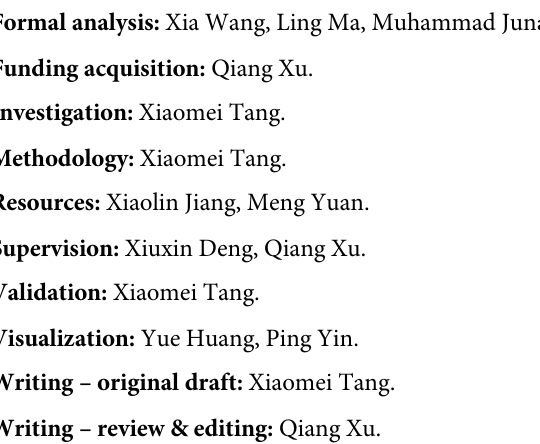
S1 Table. Number of paired-end reads counted by Illumina sequencing technology. Note: ATL and SWO represent Atalantia and sweet orange, respectively. The treatment group and control group were inoculated with Xcc and sterile water at 6 h, 24 h, and 48 h. S2 Table. List of 8 overlapping differentially expressed genes 48 h after Xcc inoculation in Atalantia and sweet orange. Note: fold-changes of gene expression level (fragments per kilo- base of transcript per million mapped reads, FPKMs) were normalized to the FPKM of the control (inoculation with sterile water at 48 h). ‘-’ indicates down-regulation. S3 Table. Differentially expressed genes (DEGs) in Atalantia and sweet orange after Xcc inoculation. ATL and SWO represent Atalantia and sweet orange, respectively. T6, T24, and T48 represent the treatment time points (inoculation with Xcc at 6 h, 24 h and 48 h); C6, C24, C48 represent the control (inoculation with sterile water at 6 h, 24 h and 48 h). S4 Table. Primer sequences used in this